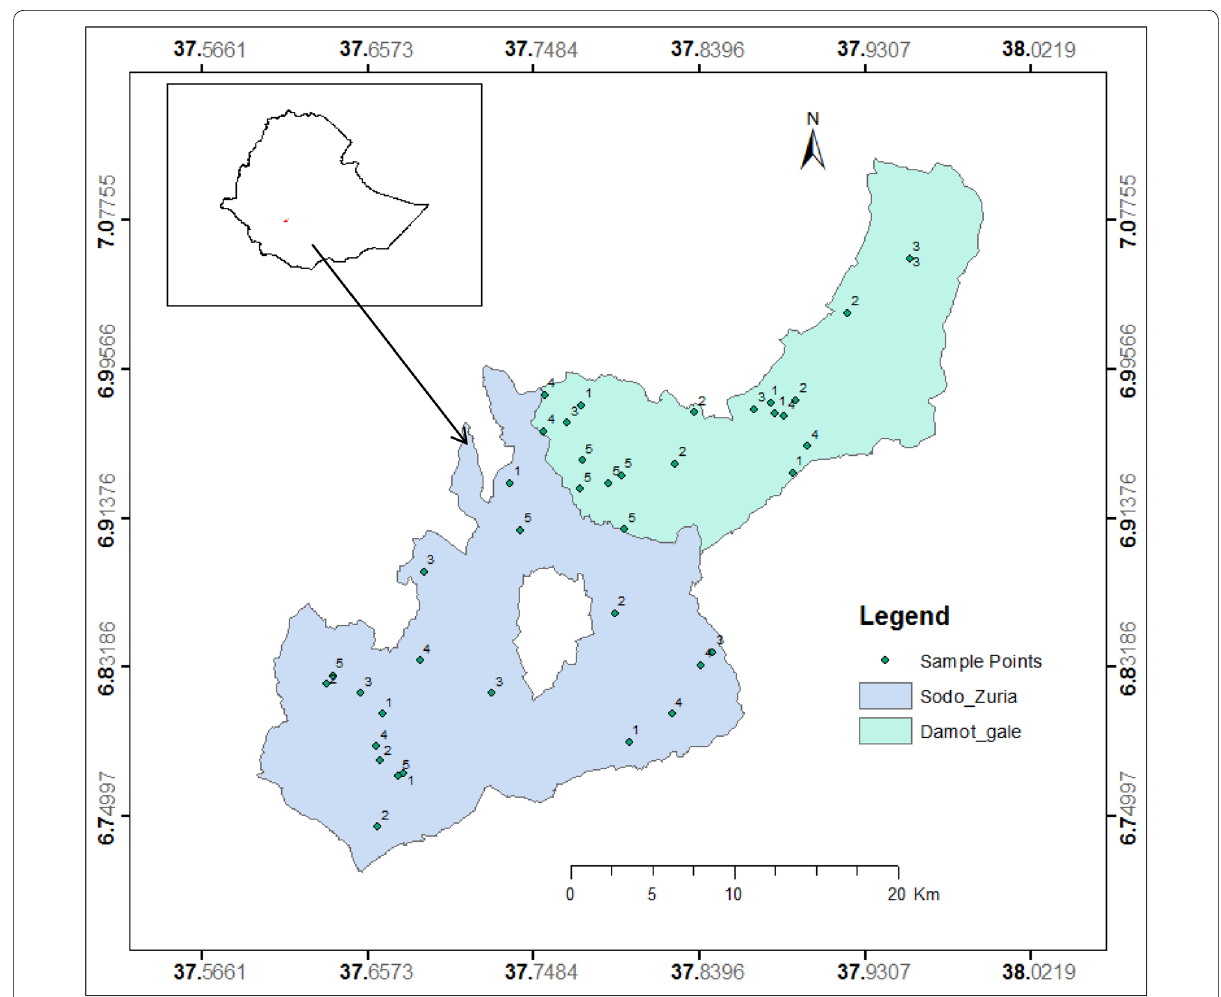
Table 1 Characteristics of land use practices among fields in the farm Field